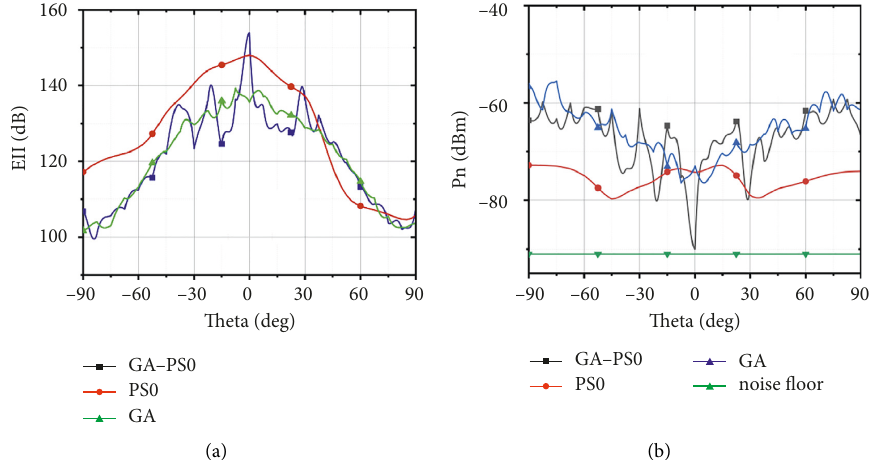
Figure 8: Comparison of performance in three cases at 10GHz with P